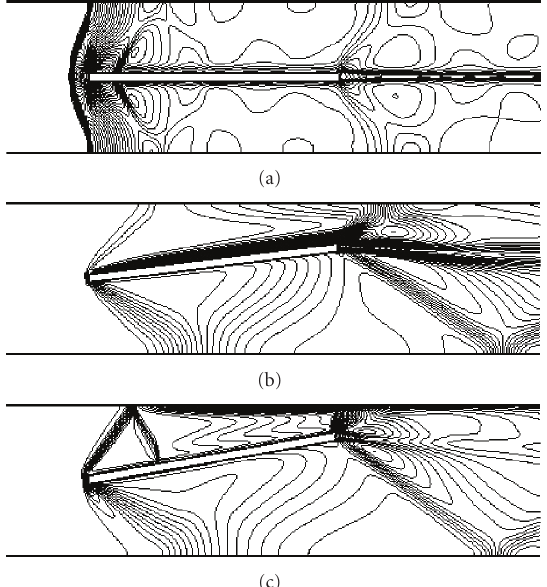
Figure 10: Iso-density contour (a) AOA = 0 ◦ , (b) AOA = 7 ◦ , (c) AOA = 10 ◦